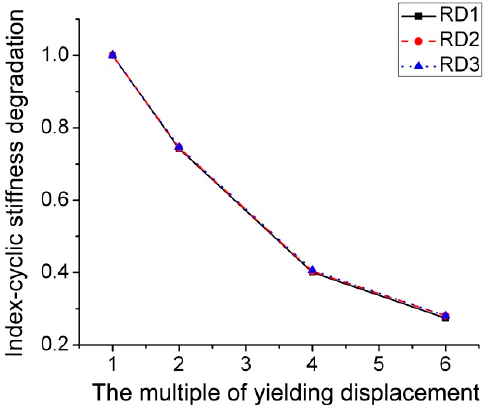
Figure 26. Index of looped rigidity degradation curves of RD series joints.